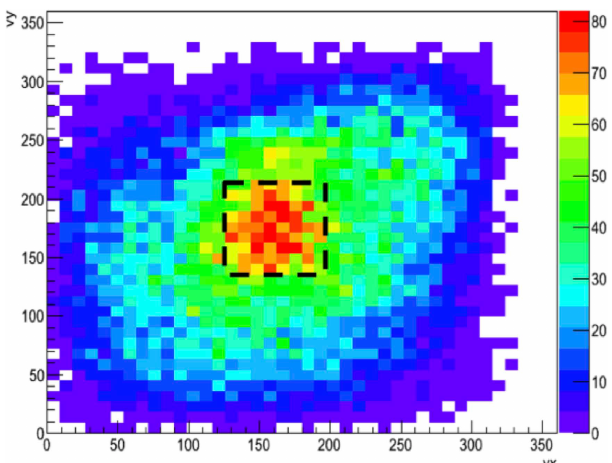
Fig. 6. Reconstructed vertex positions for events with a scattering angle larger than 30mrad due to the presence of a lead block of 10 × 15 × 10cm 3 . Units along the x- and y-axis represent the strip number; each strip is 1.5mm wide. The “true” position of the lead block is